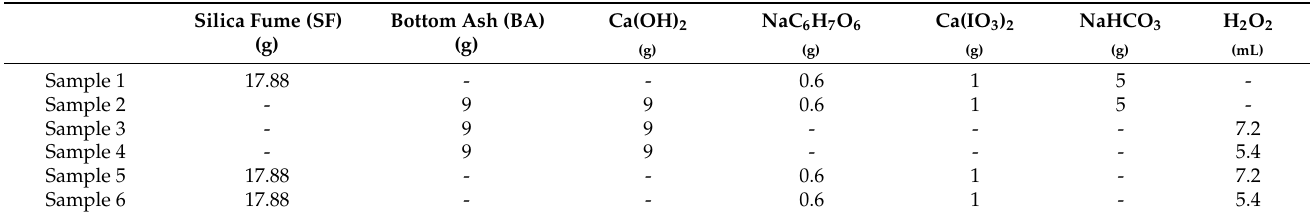
Table 1. Composition of porous samples. Samples 1, 5 and 6 were synthetized by silica fume, while samples 2, 3 and 4 were synthesized by bottom ash.